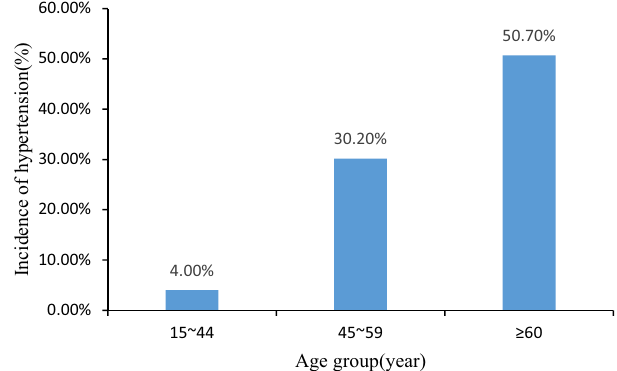
Figure 1. The prevalence of hypertension increases with age ( P < 0.05).